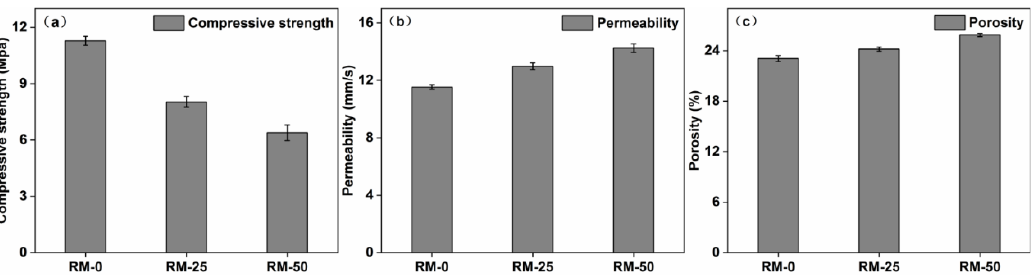
Figure 2. ( a ) Compressive strength, ( b ) permeability and ( c ) porosity of RMPC with different red mud contents.